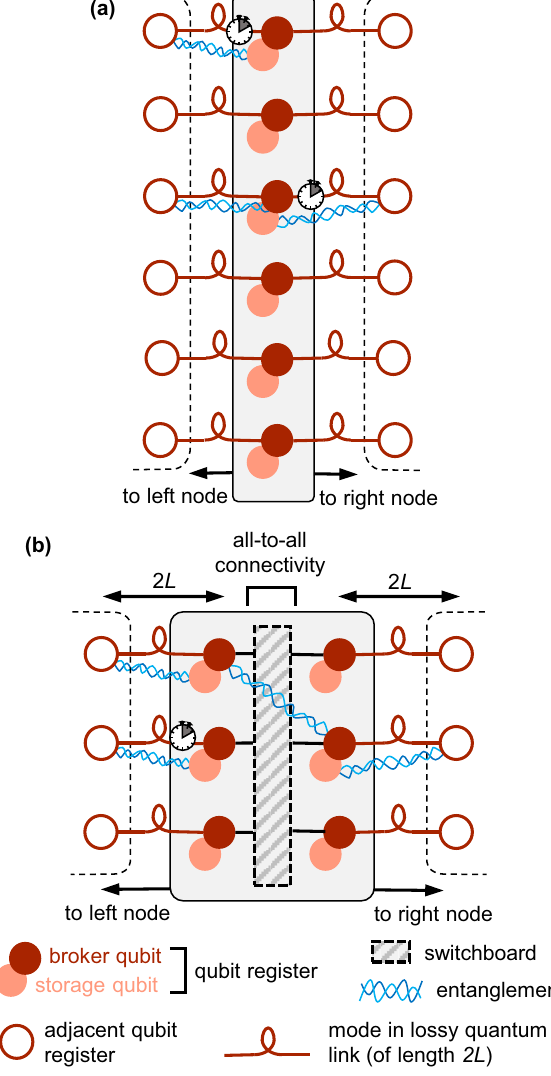
Fig. 2 Abstract representation of a 2-way standard repeater and a 2-way router in a quantum network. Each repeater node hosts m qubit registers, each of which here is formed by an NV center in diamond comprising a optically active electron spin (dark red) coupled to a long-coherence nuclear spin (light red), where the former serves as a broker to store entanglement in the latter. Multiple optical modes can be transmitted through the same physical link, e.g., via temporal or spectral multiplexing. a Standard routerless repeater. In a standard repeater, each qubit register has lossy quantum links to registers at adjacent network nodes on both the left and the right. b Router. In our router architecture, each qubit register has lossy links to only one of the left or right neighbors; however, the repeater node contains local, low-loss quantum channels that enable entanglement generation between all registers in the left bank and all registers in the right bank. As a result, the mean time a storage qubit must idle t idle while holding entangle- ment is shorter with a router. The idling time depends on t distant (the network clock period), t local (the local clock period), p distant and p local (the probability of generating entanglement over a distant and local link, respectively). hold entanglement can be greatly reduced, decreasing errors due to decoherence. Second, the number of entanglement attempts a register must make while its storage qubit holds entanglement is reduced by a factor p local / p distant , thus sharply reducing the